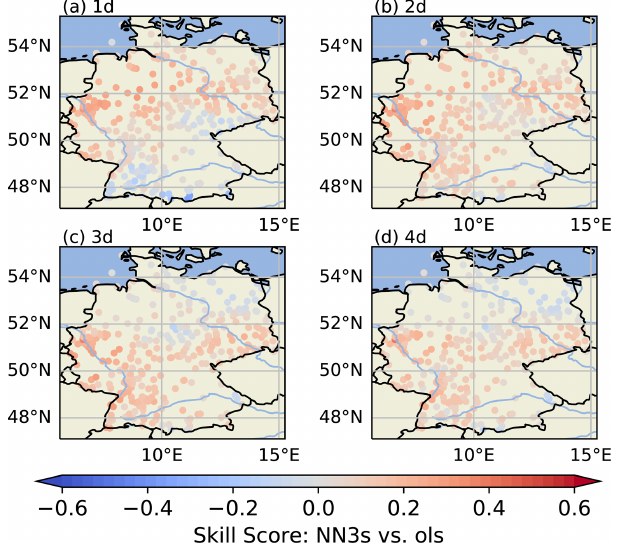
Figure 9. MSE of the training (left triangle), validation (right tri- angle) and testing (bottom triangle) data sets for each station. This figure was created with Cartopy (Met Office, 2010–2015). Map data © OpenStreetMap contributors 2022. Distributed under the Open Data Commons Open Database License (ODbL)